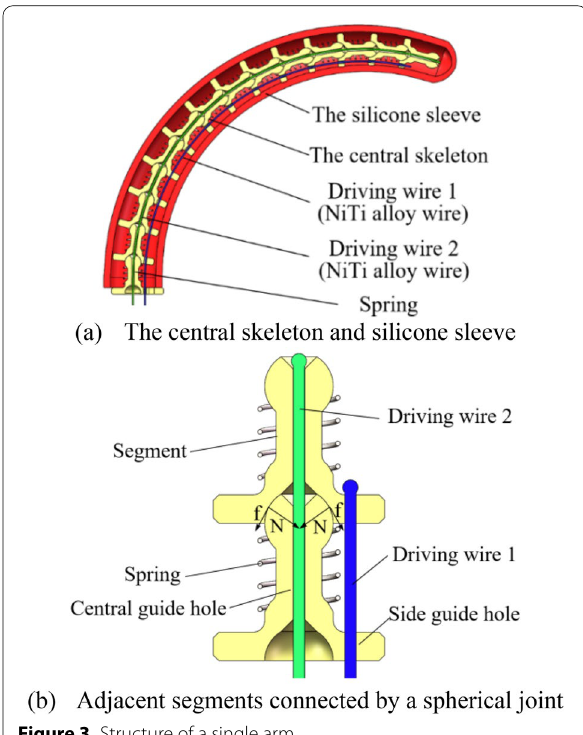
Figure 3 Structure of a single arm